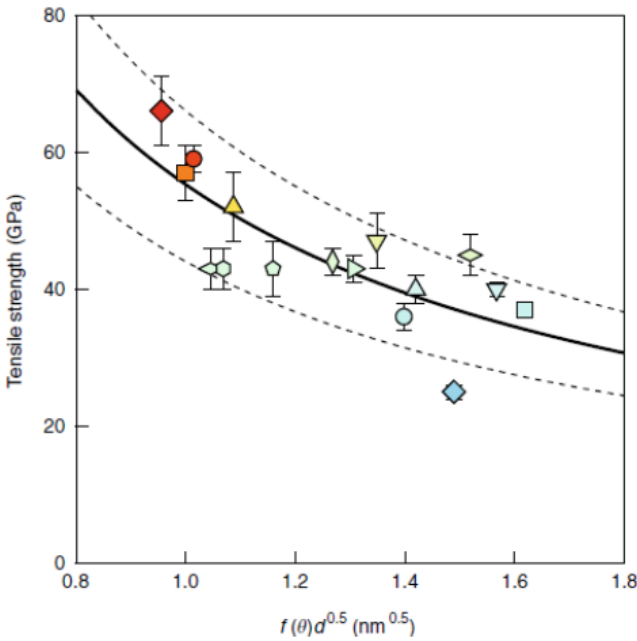
Figure 4. Relationship between tensile strength and nanotube geometry, showing the dependence of strength on the chiral angle and diameter [28]. Used with permission from Springer Nature.